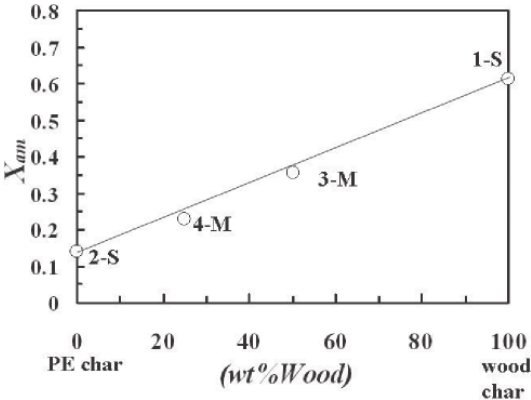
Fig. 5: Relationship between fraction of amorphous carbon and percentage of wood addition to